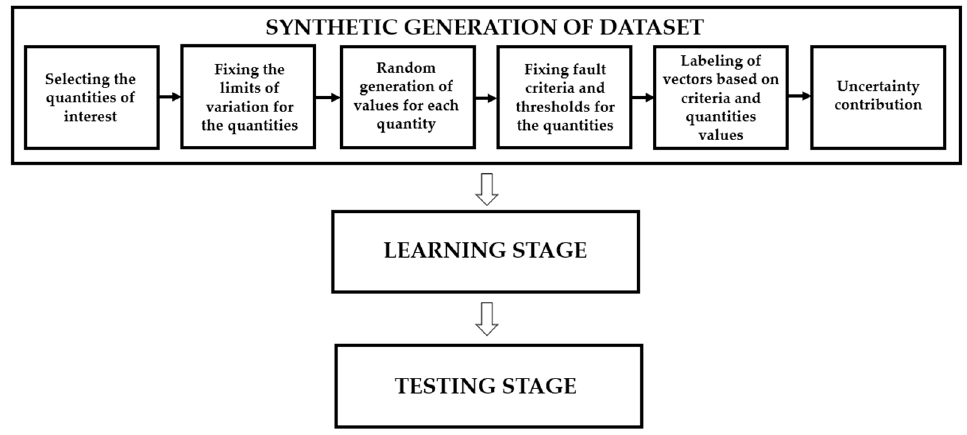
Figure 4. Flowchart of the algorithm.